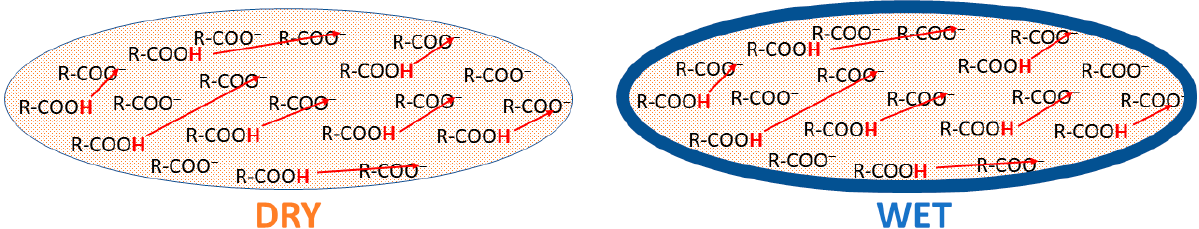
Figure 10. Carboxylic groups are strictly fixed inside the melanin particles and cannot migrate when the humidity changes. If the distances between carboxyls do not change, then the mobility of protons, determined by these distances between local states, should remain almost stable.